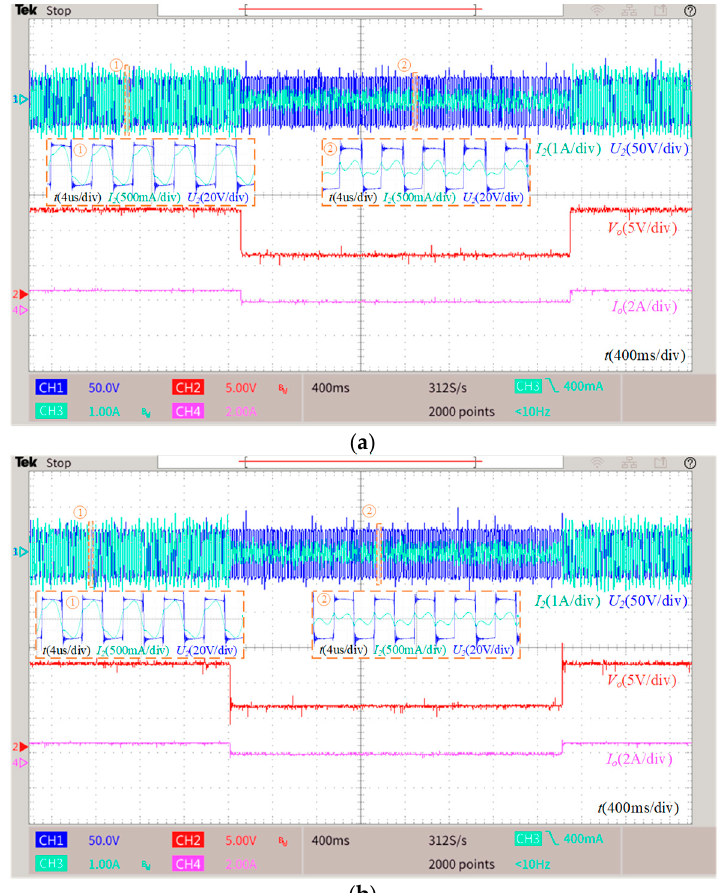
Figure 8. Tracking performance in Case 2 with resistance load, ( a ) PI control, and ( b ) FTSM-ELM control.